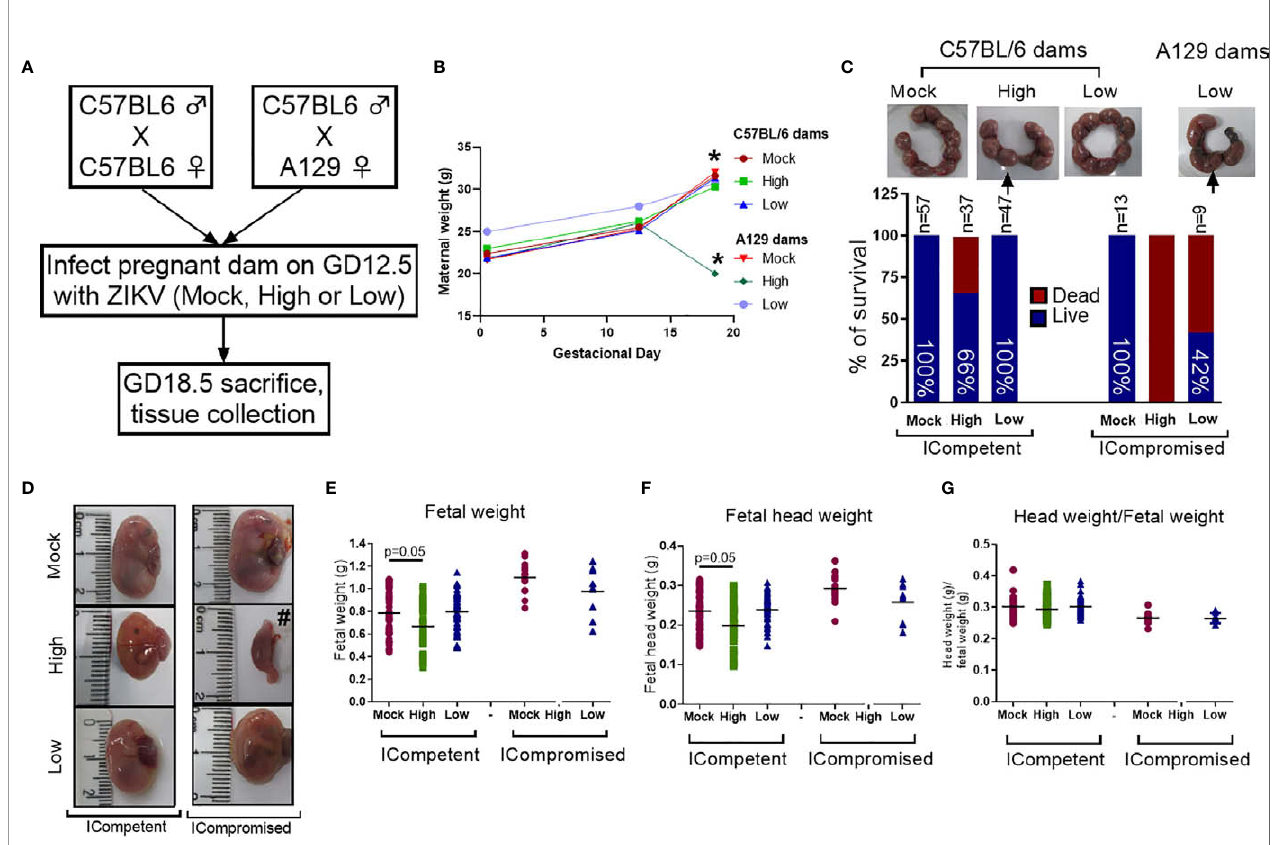
FIGURE 1 | ZIKV infection induced fetal changes during pregnancy. (A) Experimental design: matings of C57BL/6 dams x C57BL/6 sires (mock n=11 dams; high ZIKV n=15 dams; low ZIKV n=9 dams) and A129 dams x C57BL/6 sires (n=3 dams/group). The mock control consisted of noninfected C6/36 cell supernatants; high ZIKV titers consisted of 5x10 7 plaque-forming units (PFU) of ZIKV PE243, and low ZIKV titers consisted of 10 3 PFU of ZIKV PE243. Fetuses from C57BL/6 dams and sires were termed ICompetent, whereas fetuses from A129 dams and C57BL/6 sires were termed ICompromised. (B) Maternal weight gain throughout pregnancy. (C) Uterine horn and survival rates following ZIKV exposure (arrows show resorption sites). (D) Fetal/reabsorption images (#=example of fetal reabsorption). (E) Fetal weight, (F) fetal head weight and (G) fetal head weight/fetal weight ratio. One-way ANOVA followed by Tukey ’ s posttest was used to assess changes among ICompetent groups, whereas an unpaired Student ’ s t-test or nonparametric Mann-Whitney test was used to assess differences between ICompromised groups. Values are the mean of individual plotted values. *p < 0.05, one-way